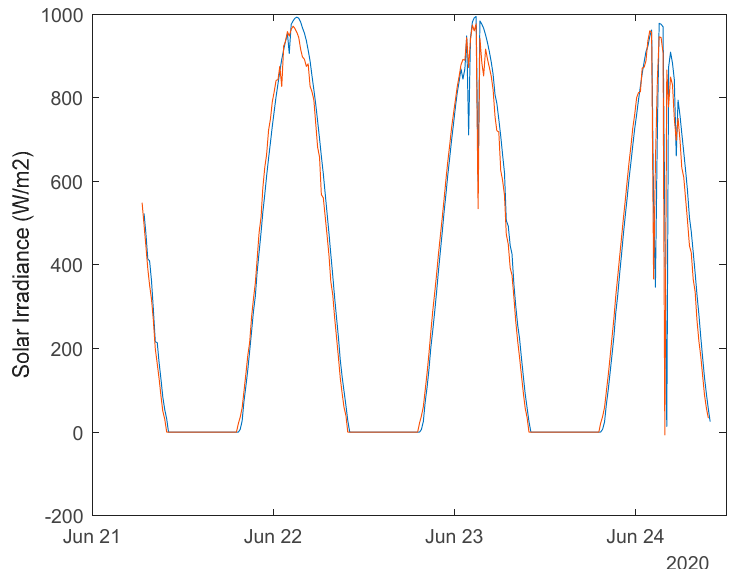
Figure 7. RMSEs of the scaled air temperature within the prediction horizon.